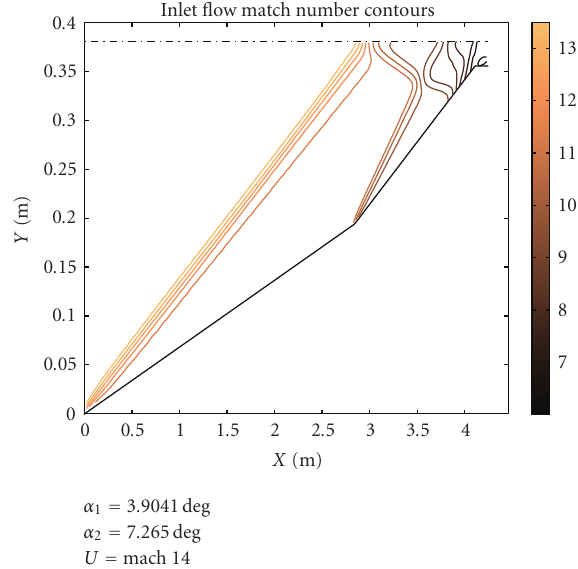
Figure 5: Final optimized inlet configuration Mach number